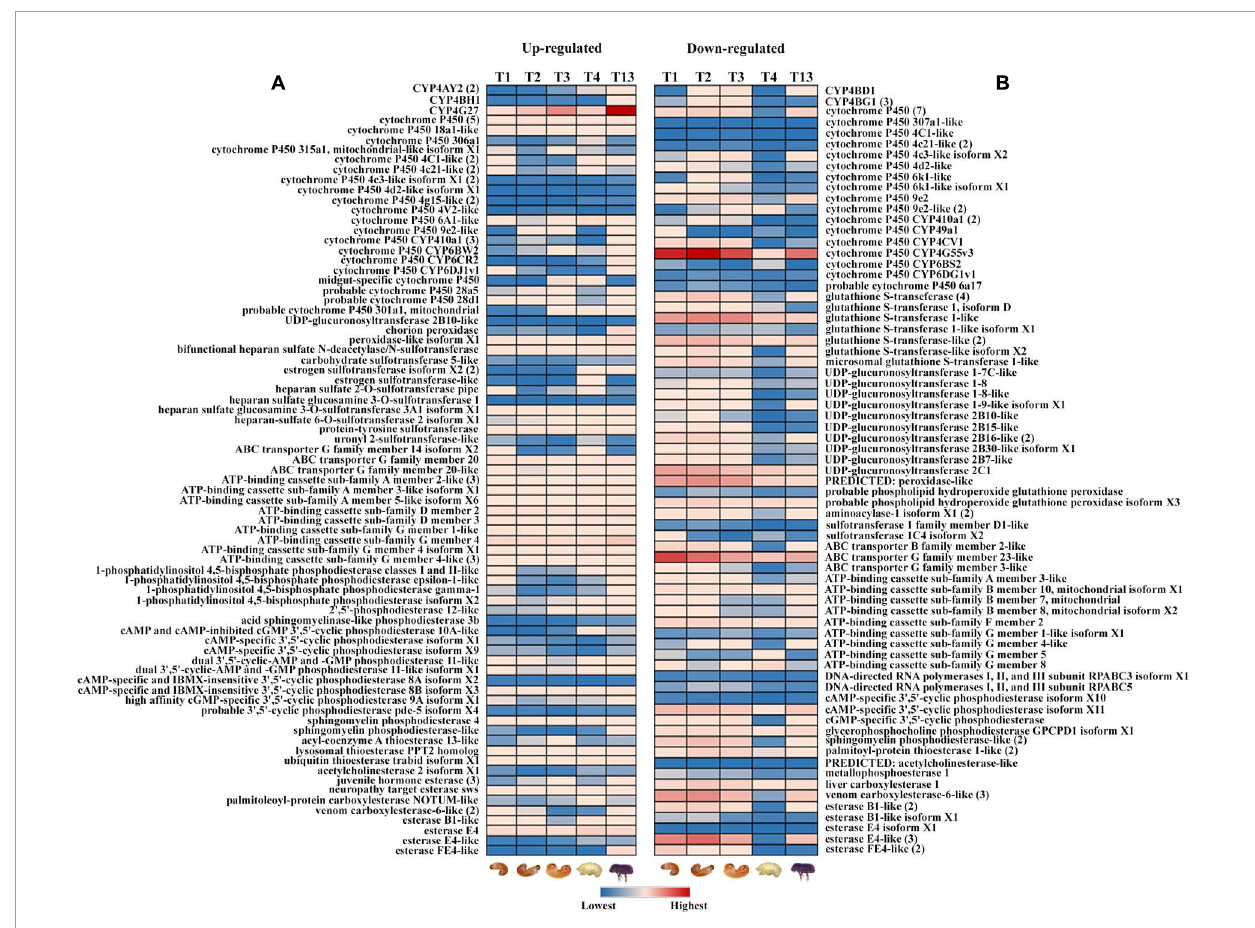
FIGURE3 Expression profile of detoxification-related genes in different life stages of ESBB. (A) Upregulated genes; (B) downregulated genes. The details of the genes are given in Supplementary Excel 3 . The expression level is represented in different colors indicating the TMM-adjusted log CPM expression mean values. Analysis was done with FDR p < 0.05 and fold change ± 2 cut-off in CLC workbench (21.0.5, Qiagen,